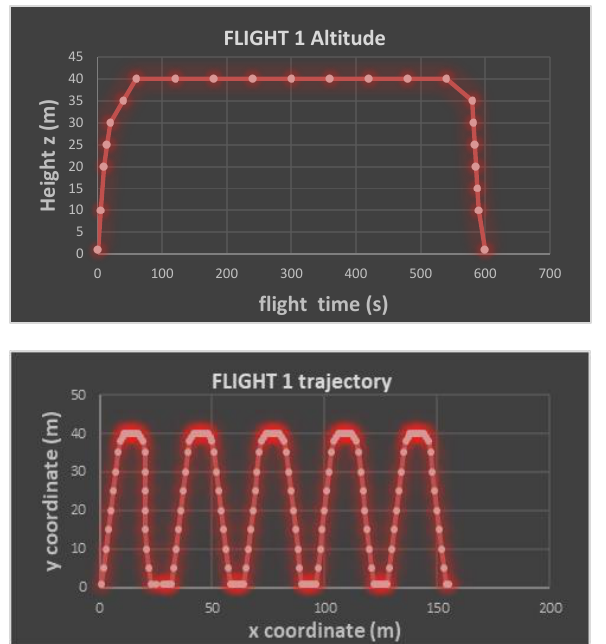
Figure 3. Altitude and planar projection of flight 1